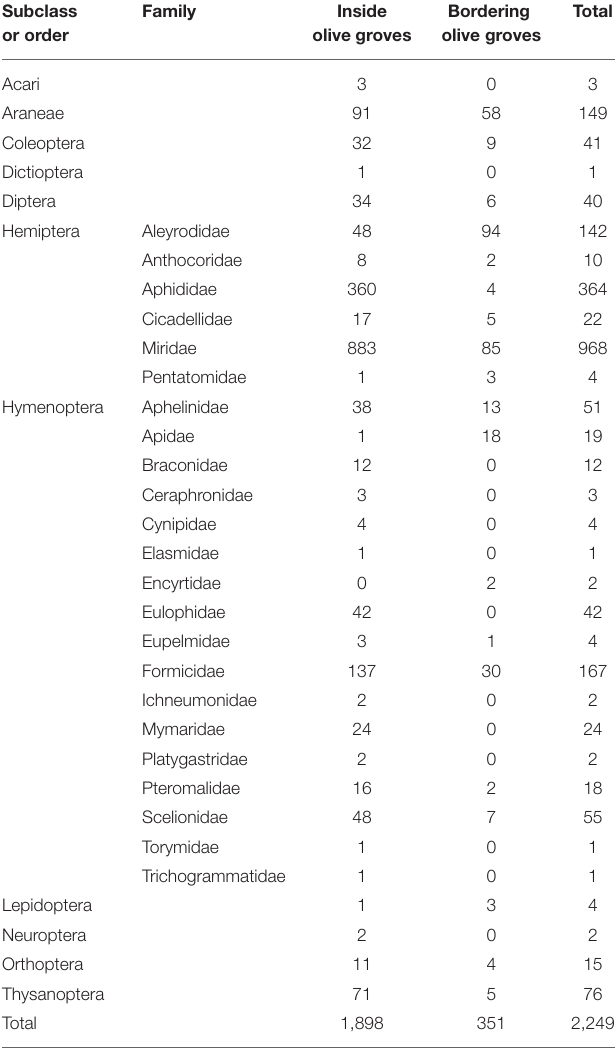
TABLE 2 | Number of individuals collected to the Order Araneae and the family Formicidae during sampling period inside and bordering olive groves. Taxonomic Inside identification olive